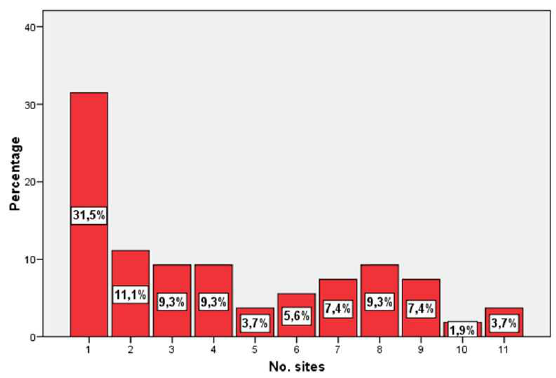
Figure 2 – Distribution of the species within the sites: percentage of species present at each